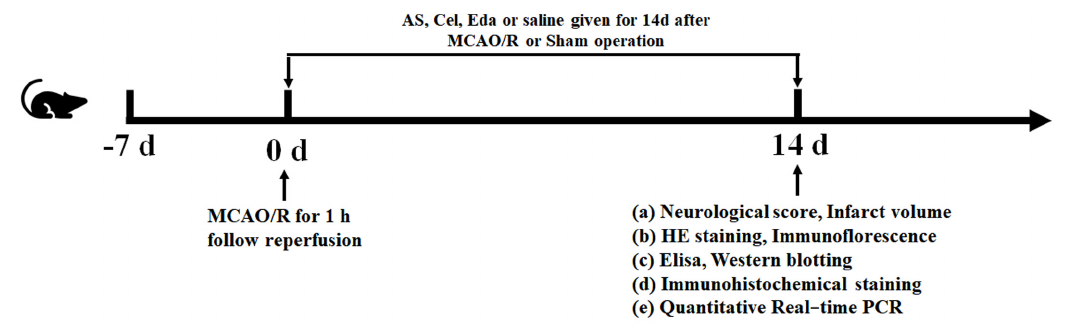
Figure 9. The schedule and design of the experiment.